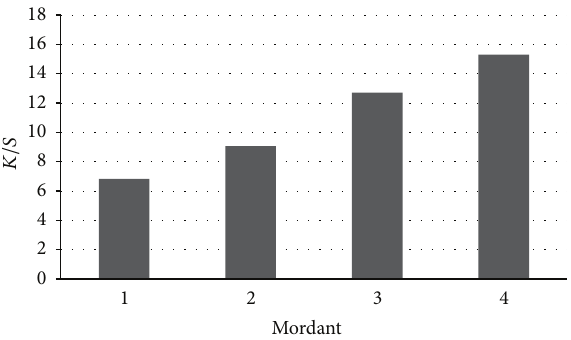
Figure 5: 𝐾/𝑆 graph of the dyed polyamide fabric samples with 5% walnut (O.W.F.): (1) un-mordanted, (2) potassium aluminum sulfate, (3) cupric sulfate, and (4) ferric sulfate.